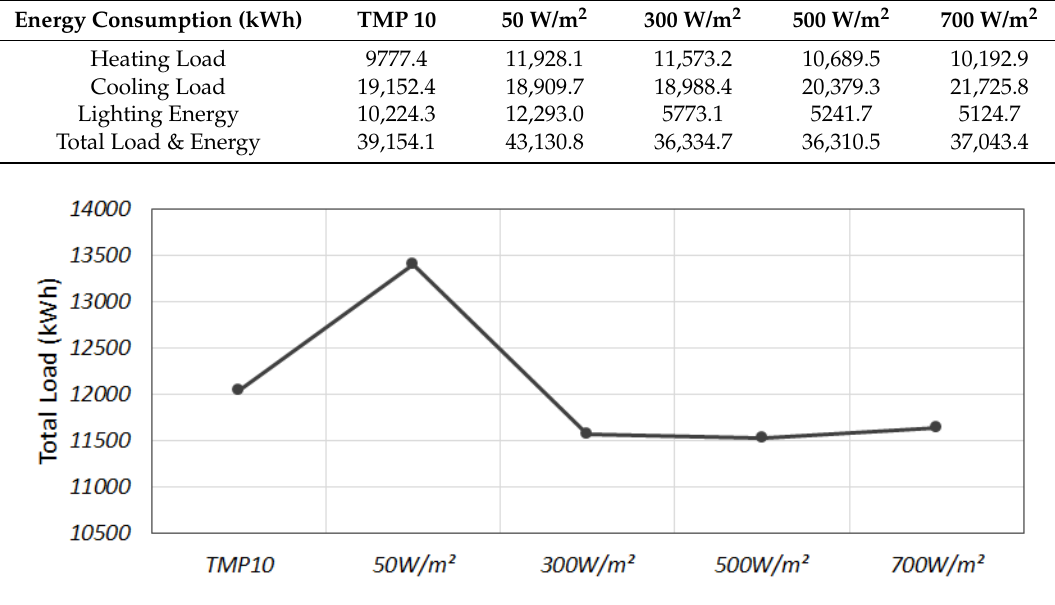
Figure 13. Electrochromic glass’ controlling conditions and annual energy consumption rate.